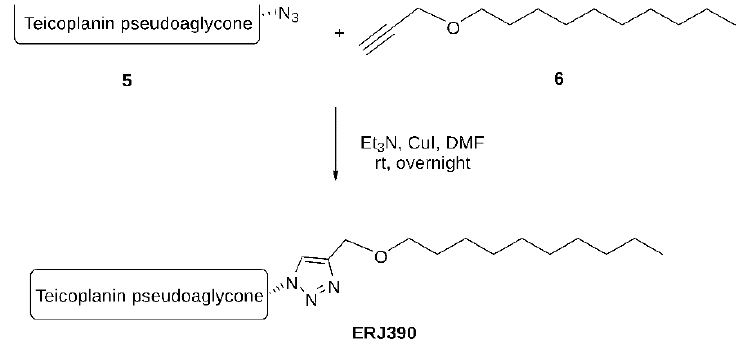
Figure 9. Schematic representation of the ERJ390